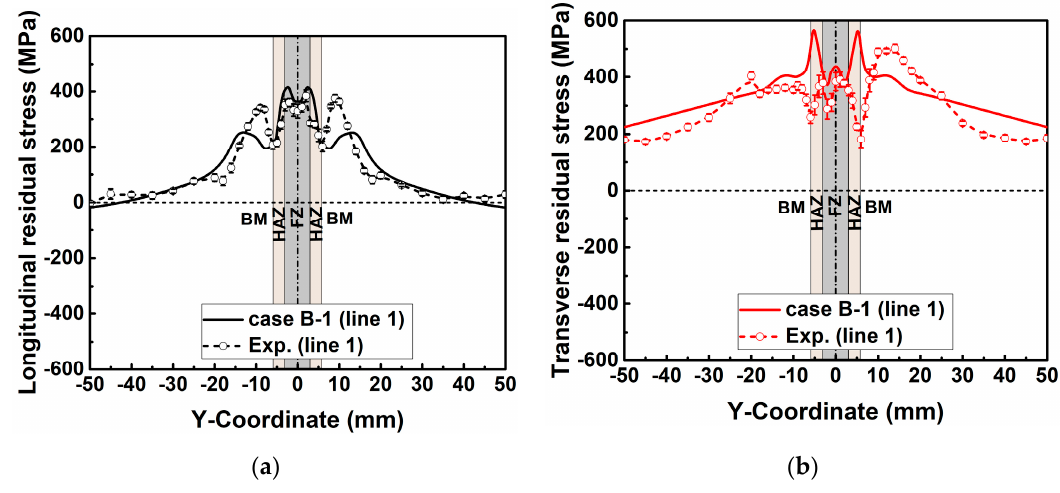
Figure 12. Welding residual stress distributions along line 1: ( a ) Longitudinal residual stress; ( b ) transverse residual stress.